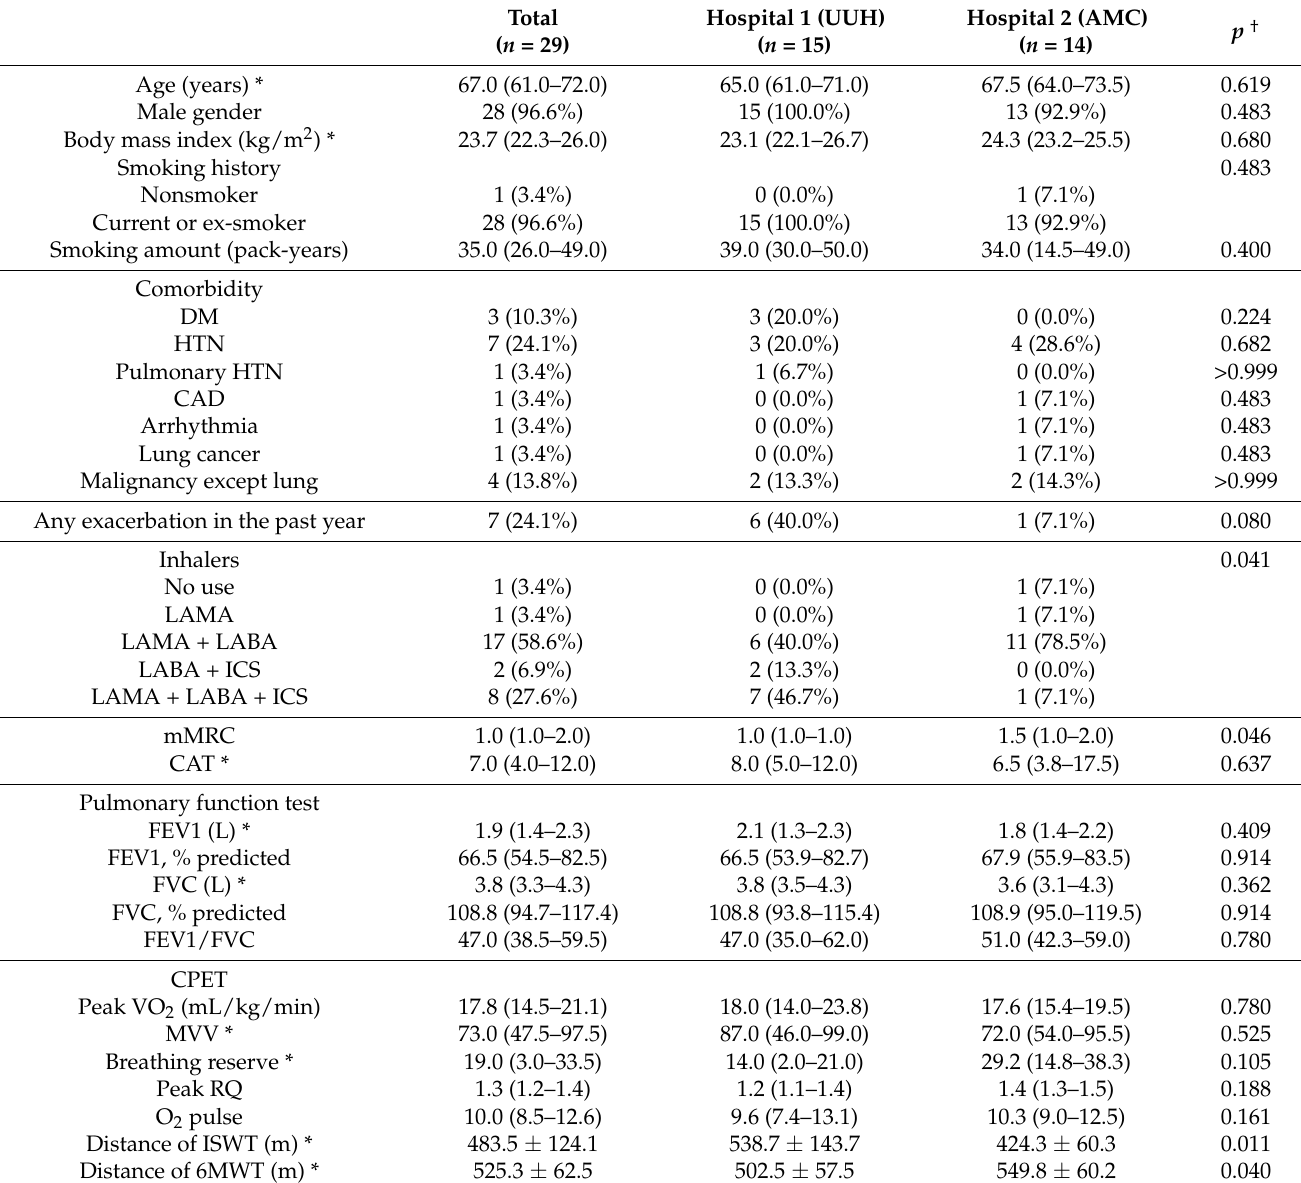
Table 1. Baseline characteristics of study